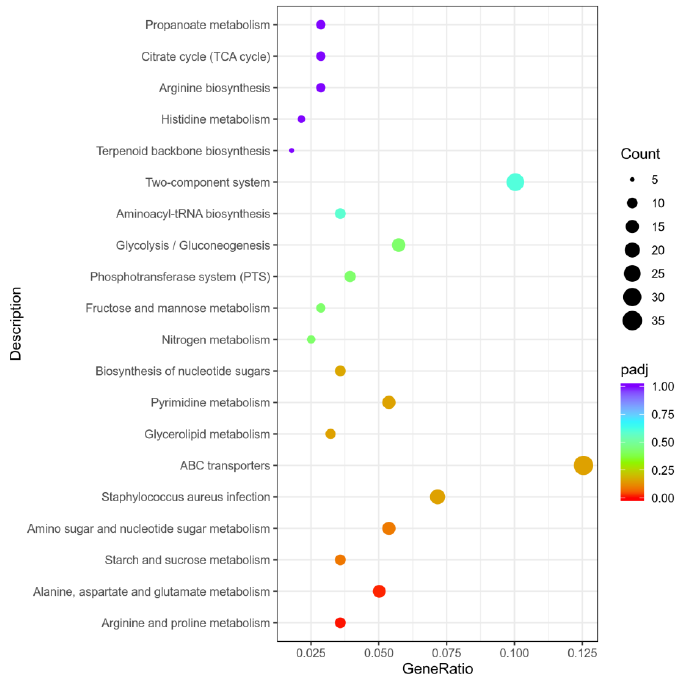
Figure 8. Top 20 statistics of down-regulated pathway enrichment of MRSA (USA 300). Among the most differentially expressed genes, the log2 multiples of adhE , alD , gap , and pruA were −6.19, −6.03, −3.08, and −2.11 (Table 3), respectively. These genes encode ethanol, acetaldehyde dehydrogenase, alanine dehydrogenase, phosphate dehydrogen- ase, and tabglutamate semialdehyde dehydrogenase, respectively. Then, real-time PCR